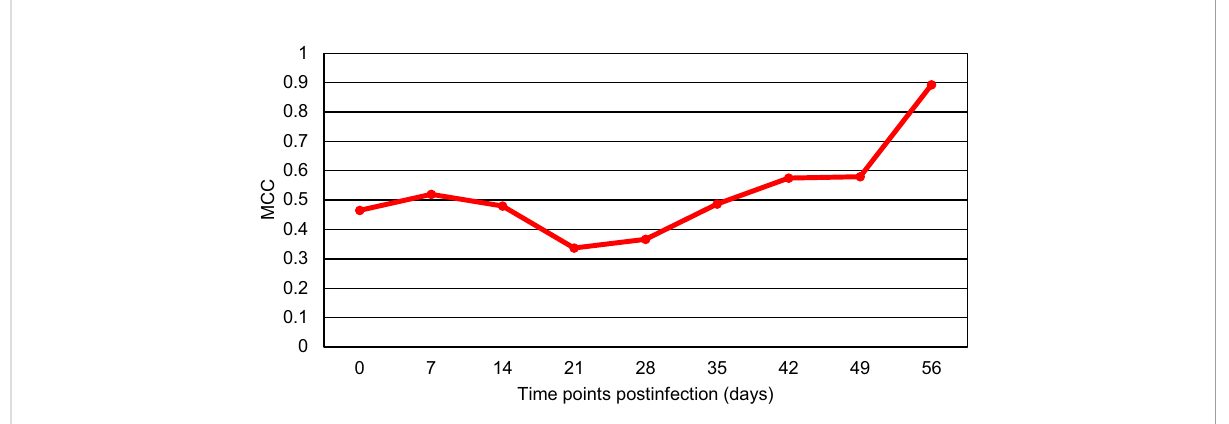
FIGURE 3 The Matthew ’ s Correlation Coef fi cient (MCC) for the binary model comparing blood samples of all Borreliella -infected mice to blood samples of all uninfected controls for each time point. Mouse blood was sampled from C3H mice prior to their infection and postinfection with B afzelii Pgau (PGAU), B garinii PBi (PBI), or B burgdorferi N40 (N40). The blood was also collected from age- and sex-matched uninfected (control) C3H mice.